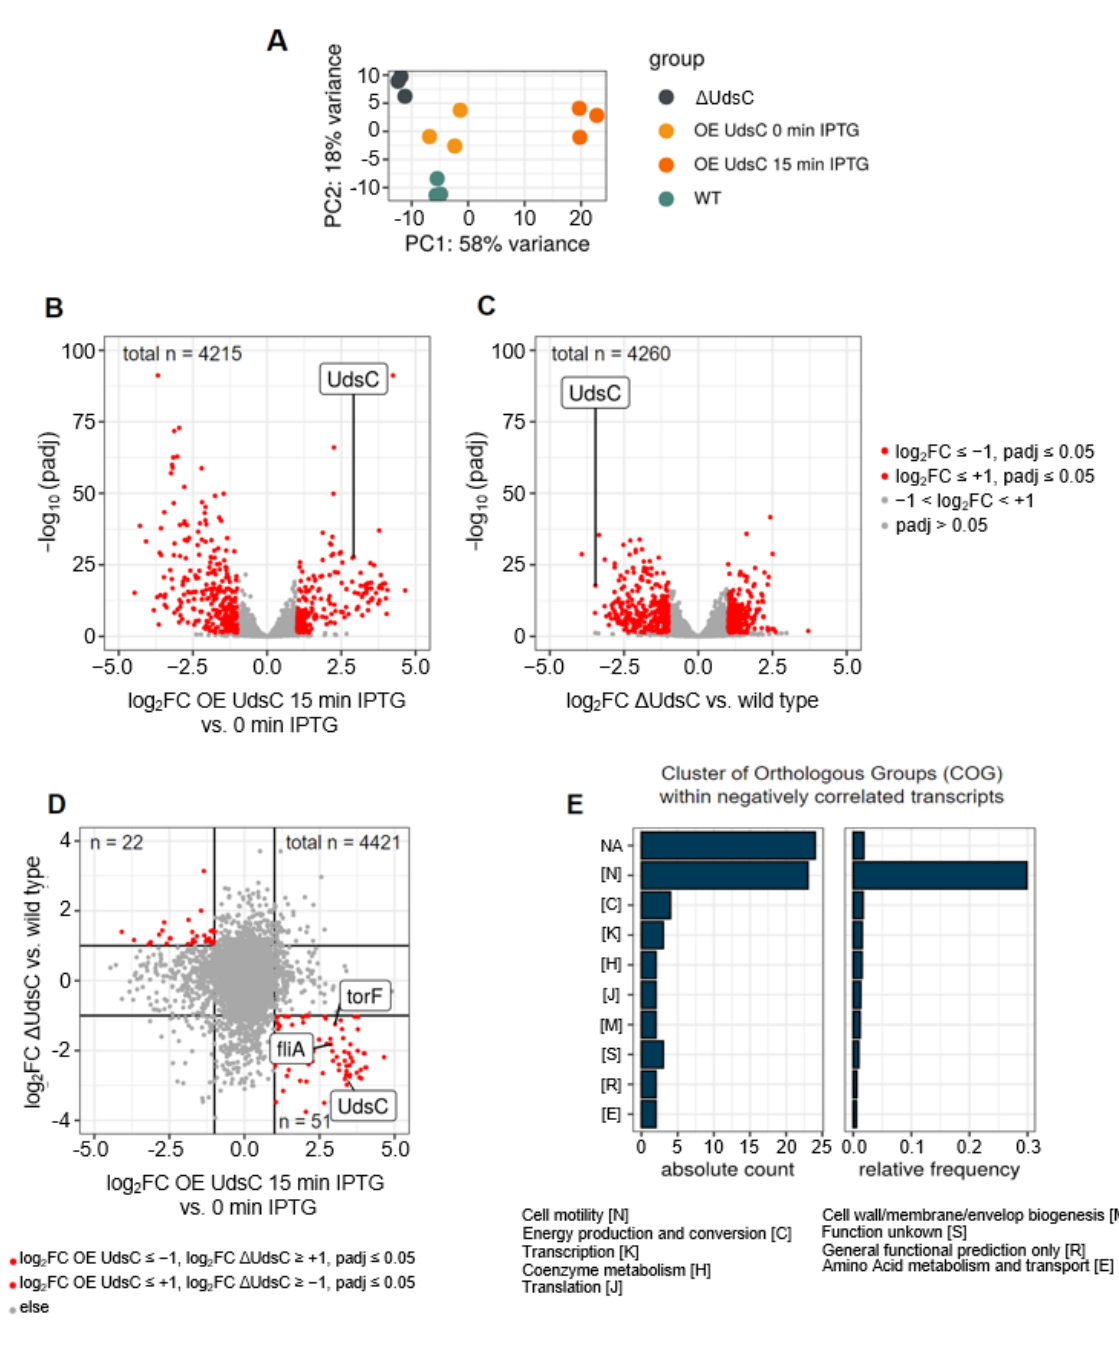
5S rRNA as loading control (lower panels). ( B ) The signals for UdsC were normalized to 5S rRNA and plotted for the different time points after IPTG addition. The bars represent the mean of the single measurements (dots), and the significance of the differences is indicated. ( C ) Northern blot from total RNA of the wild type (WT) and the strain deleted for UdsC ( ∆ UdsC) (biological triplicates) hybridized against UdsC ( upper panel) or 5S rRNA ( lower panel). ( D ) Growth curves of WT, UdsC knockout ( ∆ UdsC) and the overexpression strain (with or without IPTG added) under microaerobic and phototrophic conditions. The lines represent the mean of biological triplicates, and the standard deviations are indicated (shade).